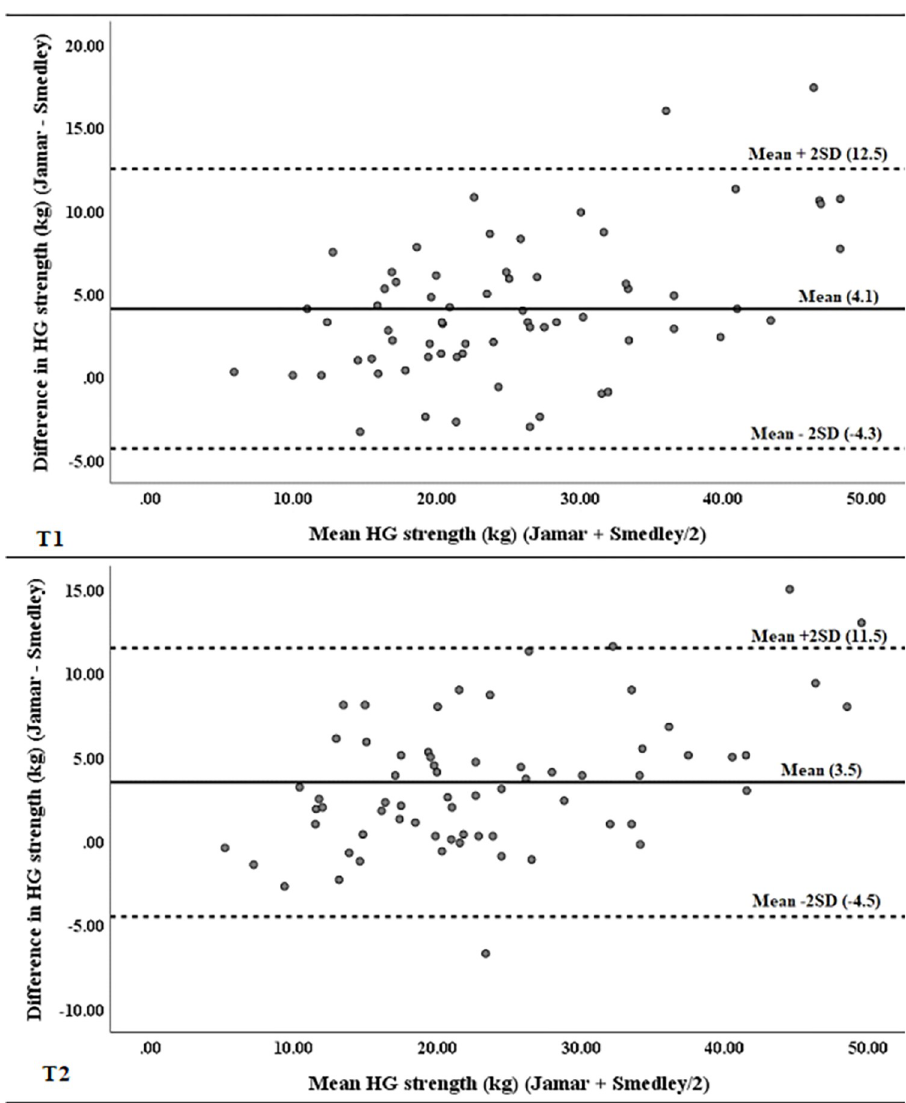
Fig 2. Bland-Altman plots for differences against mean values of hand grip strength measured with the Jamar and Smedley dynamometers at T1 (top) and T2 (bottom).